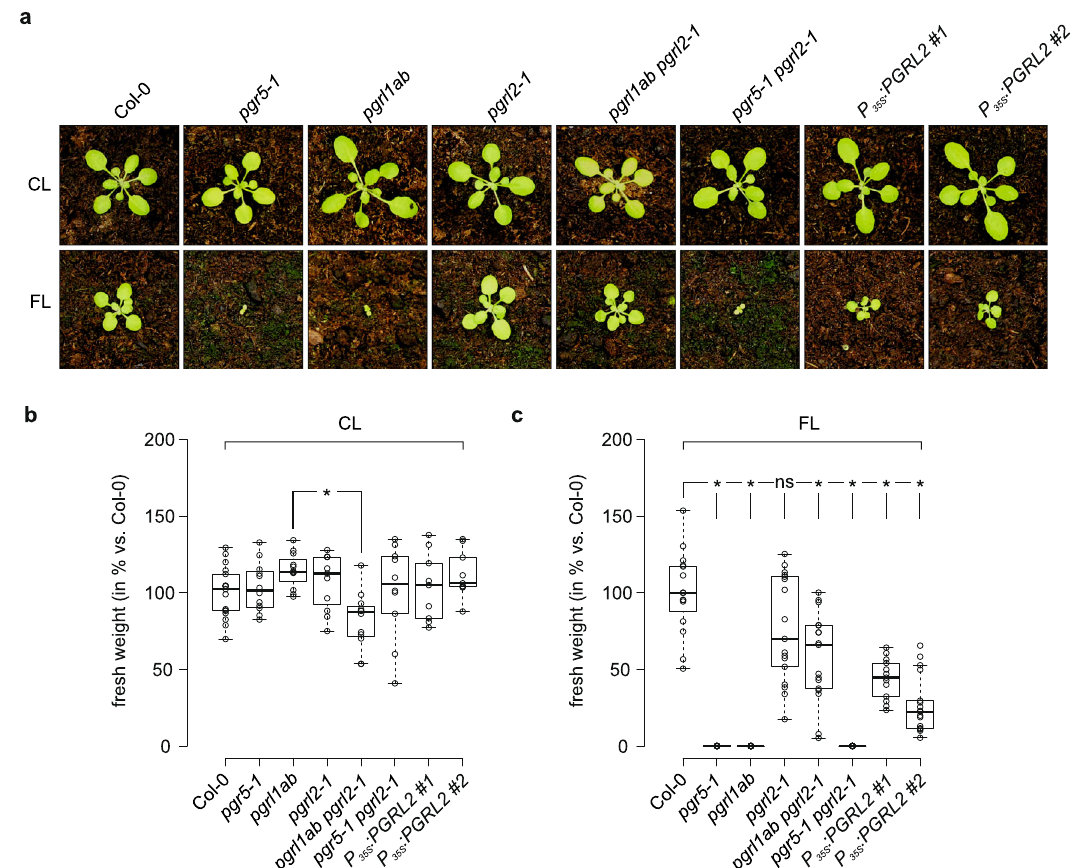
Fig. 2 Plants can survive under fl uctuating light conditions when both PGRL1 and PGRL2 are absent. a Images of 5-week-old WT (Col-0) plants, mutants ( pgr5-1 , pgrl1ab , pgrl2-1 , pgrl1ab pgrl2-1 , and pgr5-1 pgrl2-1 ) and two independent P 35S :PGRL2 (Col-0 background) lines grown under either 12 h fl uctuating light (cycles of 5 min at 50 μ mol photons m − 2 s − 1 /1 min at 500 μ mol photons m − 2 s − 1 ) /12 h dark cycles (FL) or 12 h constant light (100 μ mol photons m − 2 s − 1 ) /12 h dark cycles (CL). b , c Fresh weight (in % to the average of Col-0) of rosette leaves was determined under CL ( b ) and FL ( c ). Data points of the eight genotypes are plotted as open circles ( n = 17, 12, 12, 11, 12, 10, 9, 9 in b ; n = 15, 17, 17, 17, 17, 17, 13, 17 in c ). The horizontal lines in b , c represent the median; boxes indicate the 25th and 75th percentiles. Whiskers extend 1.5× the interquartile range, outliers are represented as dots. For statistical analyses in panel b , c , the non-parametric Kruskal – Wallis test was performed, followed by pairwise Dunn ’ s tests. The p -values were adjusted on an experiment level using the Benjamini – Hochberg method. Statistically signi fi cant differences are marked with asterisks (* p ≤ 0.05, ns, not statistically signi fi cant). P -value in panel b: 1.9 × 10 − 3 . P -values in c (order as displayed): 3.7 × 10 − 11 , 1.1 × 10 − 10 , 0.2, 4.5 × 10 − 2 , 5.6 × 10 − 11 , 1.2 × 10 − 2 and 3.7 × 10 − 4